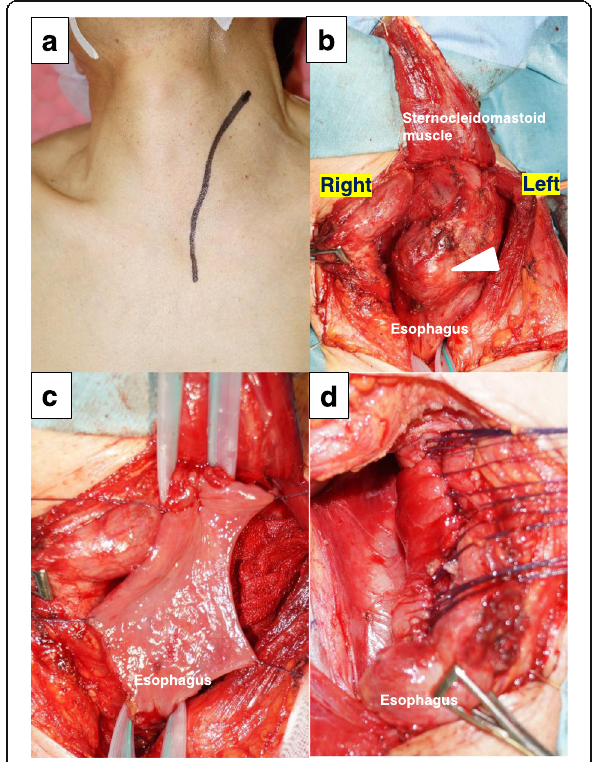
Fig. 2 Surgical approach. a The skin incision used for the cervical approach. b The tumor was found close to the upper thoracic esophagus ( white arrow ). After dividing the left sternocleidomastoid muscle, the tumor was identified easily. c The esophagus was retracted at the proximal and distal side of the tumor. The tumor was then excised, including all layers of the esophageal wall. d The esophagus was closed transversely to include each